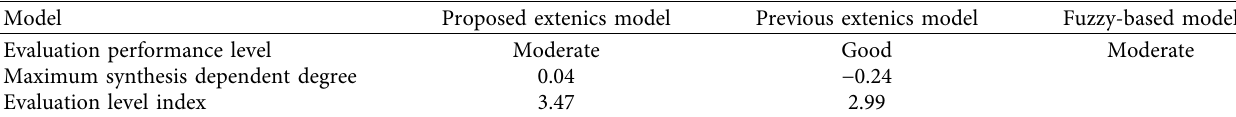
Table 6: Results derived from different